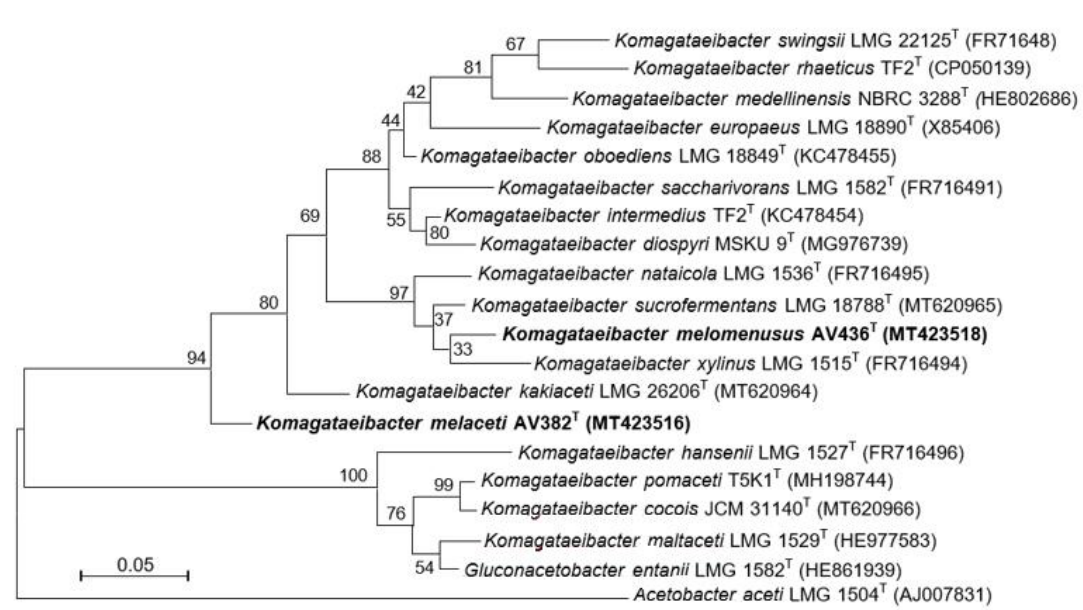
Figure 1. Phylogenetic reconstruction based on 16S–23S rRNA gene internal transcribed spacer (ITS) sequences of the type strains of species of the Komagataeibacter genus. Strains AV382 and AV436 representing novel spcies are in bold. The tree was constructed using the maximum-likelihood method. Bootstrap values are indicated at branching (1000 replicates). GenBank accession numbers are given in brackets and the scale bar represents the number of substitutions per nucleotide position.